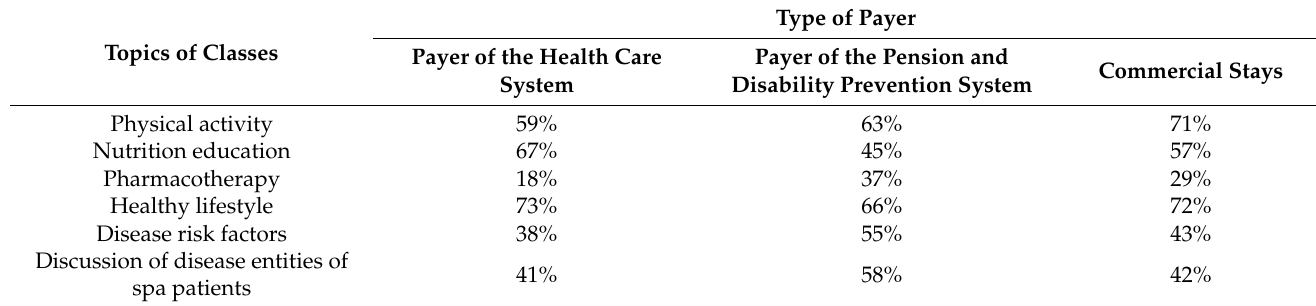
Table 2. Health education topics depending on the type of payer in the opinion of